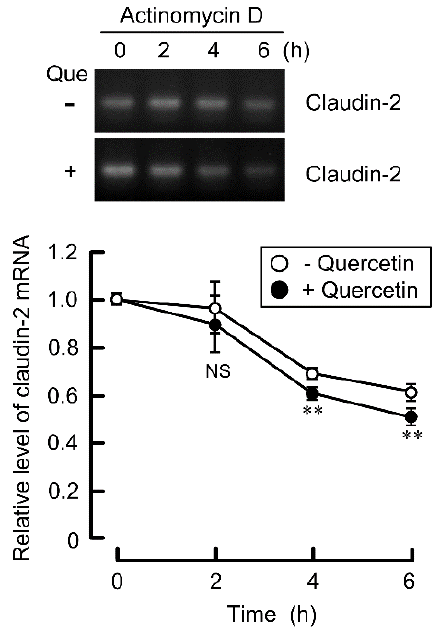
Figure 5. Decrease in the stability of claudin-2 mRNA by quercetin. A549 cells were treated with 10 μM actinomycin D in the absence and presence of 50 μM quercetin for the periods indicated. After isolation of total RNA, semi-quantitative RT-PCR (upper images) and quantitative real time PCR (lower graph) were performed using specific primers for claudin-2. n = 3. ** p < 0.01 is significantly different from